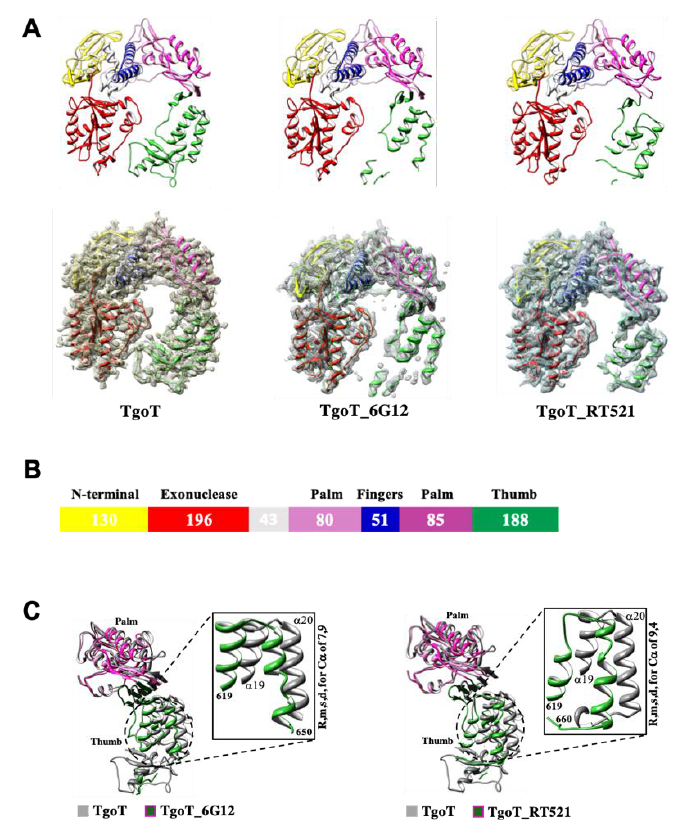
Figure 1. Structural comparison between TgoT apo form and its two variants, TgoT_6G12 and TgoT_RT521. ( A ) Cartoon representation of TgoT, TgoT_6G12, and TgoT_RT521 polymerases with a colored representation of domains (Upper panel). The domains are colored as follows: N-terminal domain (yellow), 3′ - 5′ exonuclease domain (red), palm domain (light and dark magenta for its N-terminal and C-terminal parts, respectively), fingers domain (blue), and thumb domain (green). An interhelical segment between the exonuclease and the palm domains is colored in light grey. The 2Fo–Fc X-ray electron density omit map is shown and contoured at a level of 1 σ (Down panel) as a grey mesh to illustrate the less ordered character of the thumb domain (green). ( B ) Domain organization in Tgo polB. Conserved domains are represented as colored boxes and their length is indicated. A non-conserved inter-helical segment is colored in light grey. ( C ) Overlay of the palm (light and dark magenta) and the thumb (green) domains of TgoT variants with the palm and thumb domains (grey) of TgoT. Broader movements observed in the thumb domains are highlighted with a zoom on helices S and T (r.m.s. deviation for C α of 7.9 Å for TgoT_6G12 and 9.4 Å for